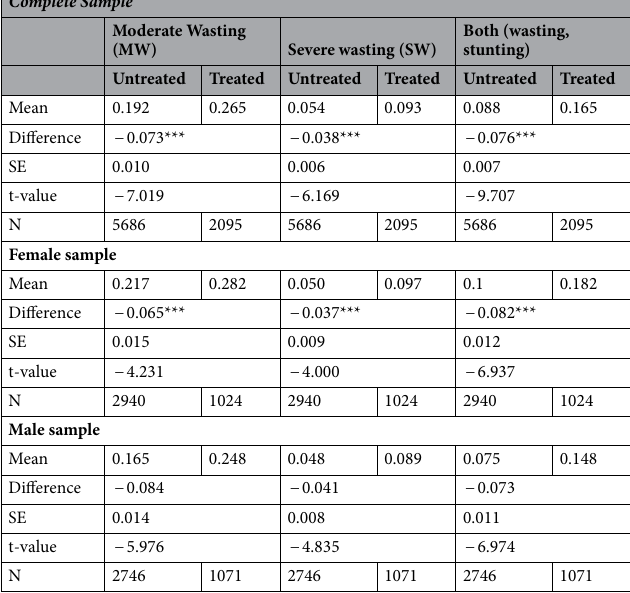
Table 2. Two-sample test of proportions between LBW and NBW